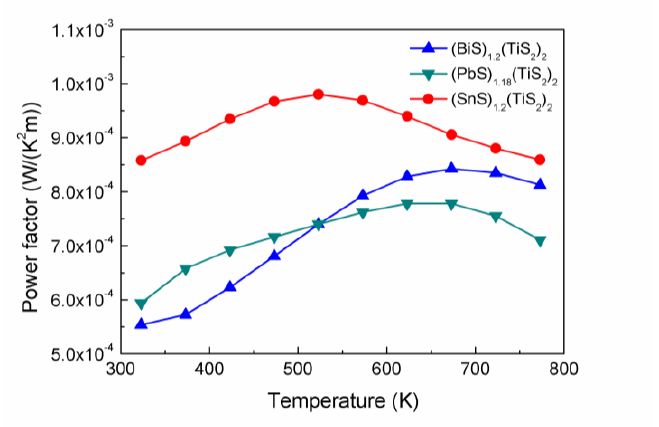
Figure 8. Total thermal conductivities ( k total , solid line) and electron thermal conductivities ( k , dashed line) of (BiS) e